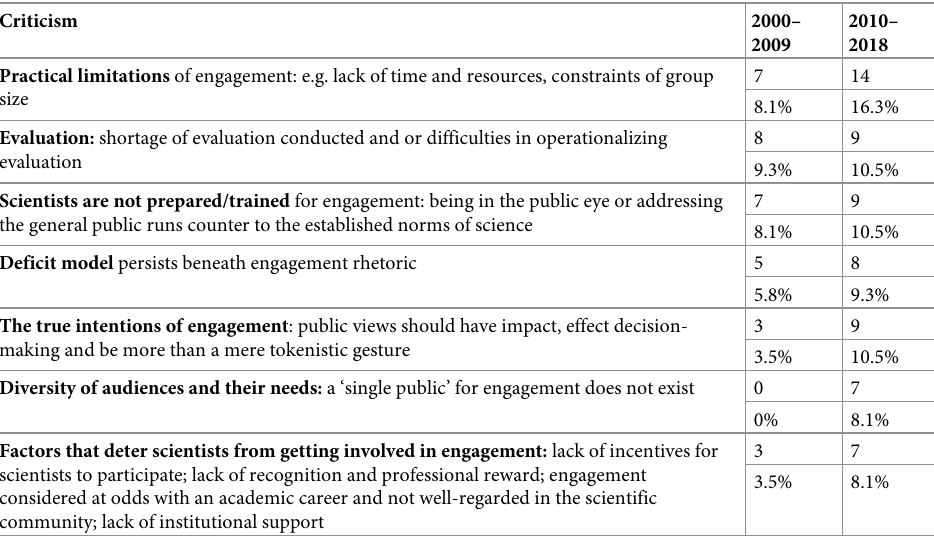
Table 3. Prominent criticisms of engagement in academic